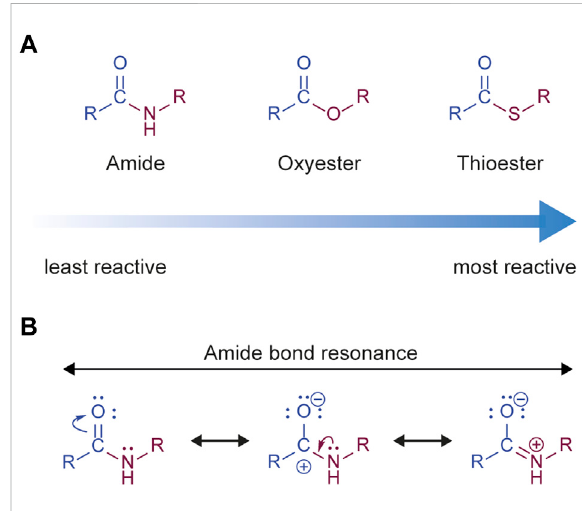
The relative reactivity of ubiquitin conjugating bonds. (A) The amide group is the least reactive, and therefore the most stable, of the acyl groups formed during ubiquitylation. The thioester is the most reactive, and therefore the least stable, whereas the oxyester is somewhere in between. (B) The stability of the amide bond is due to stabilization of the partial positive charge on the carbonyl carbon by electron donation from non-bonding electrons on the adjacent nitrogen, thus decreasing electrophilicity. In contrast, thioesters exhibit much weaker resonance stabilization due to poor overlap between the electron orbitals in sulfur and